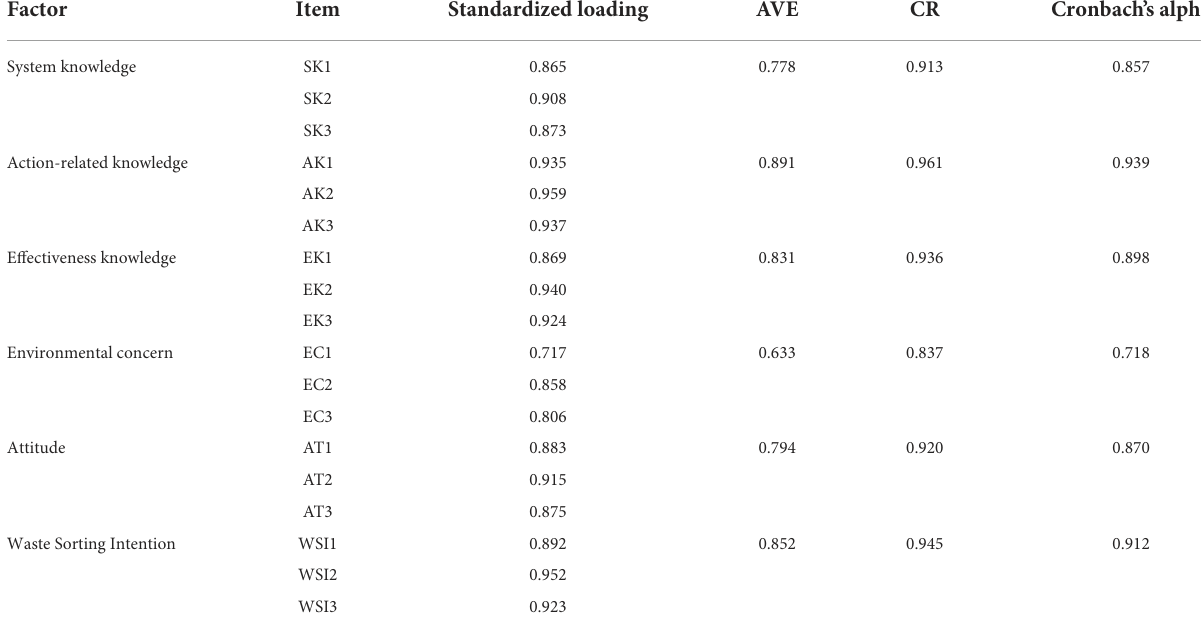
TABLE 2 Standardized item loadings, AVE, CR, and alpha values. Factor Item